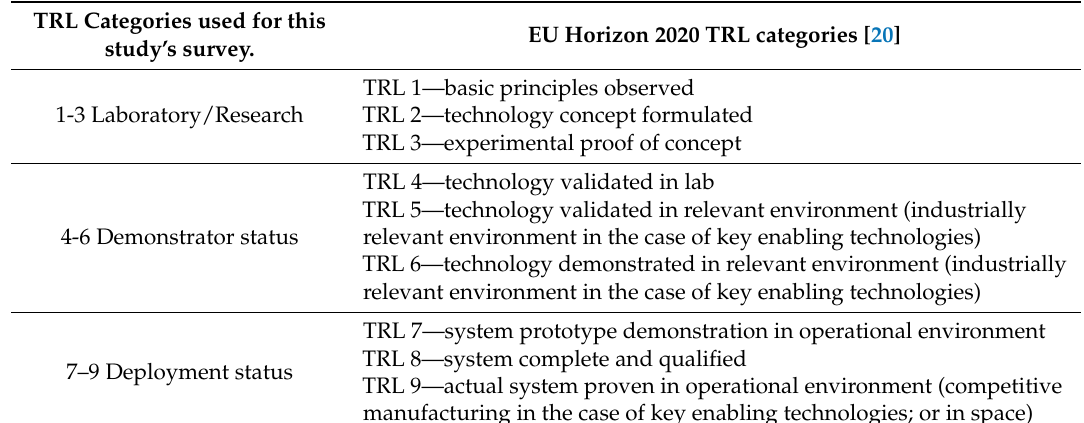
Table 1. Technology Readiness Levels (TRL) categories provided to survey respondents (in comparison to EU Horizon 2020